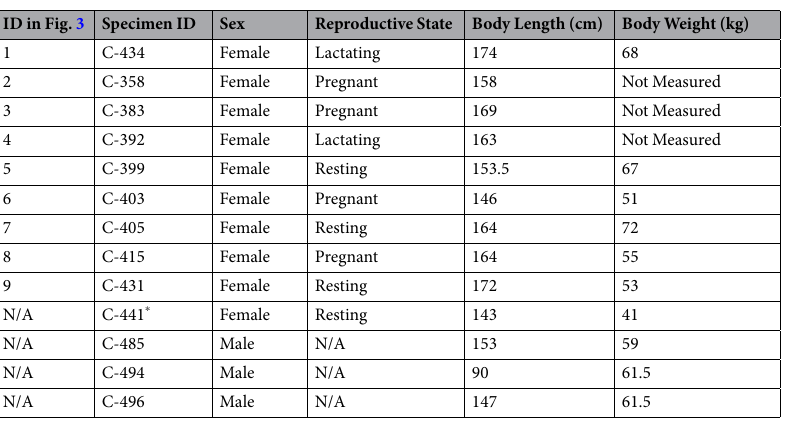
Table 1. Sex, reproductive state, and body sizes of the post-mortem harbor porpoises. * Specimen positioned in ventral recumbency, unlike the other female